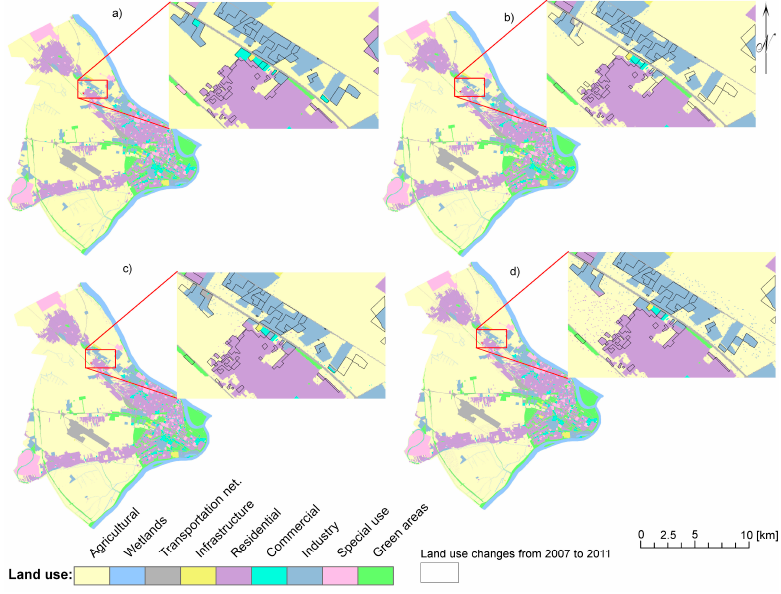
Figure 5. Generated maps for best performing models for year 2011 ( a ) Actual land-use and forecasts obtained with ( b ) Decision Trees (DT), ( c ) Neural Networks (NN), and ( d ) Support Vector Machines (SVM).